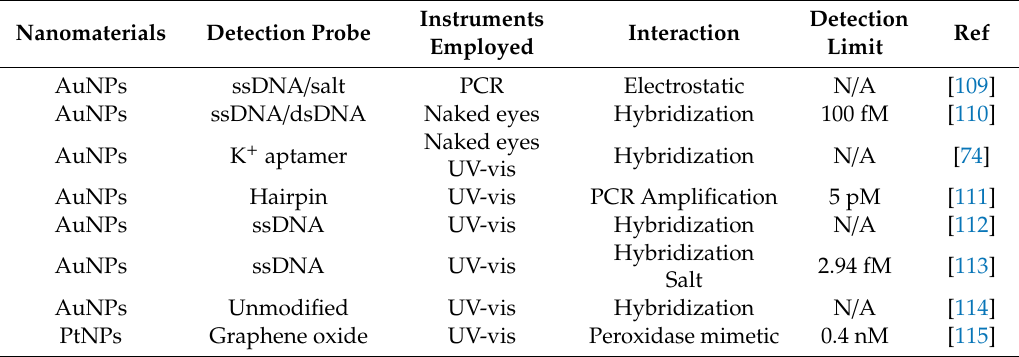
Table 2. Recent reported AuNPs-based colorimetric biosensors for DNA